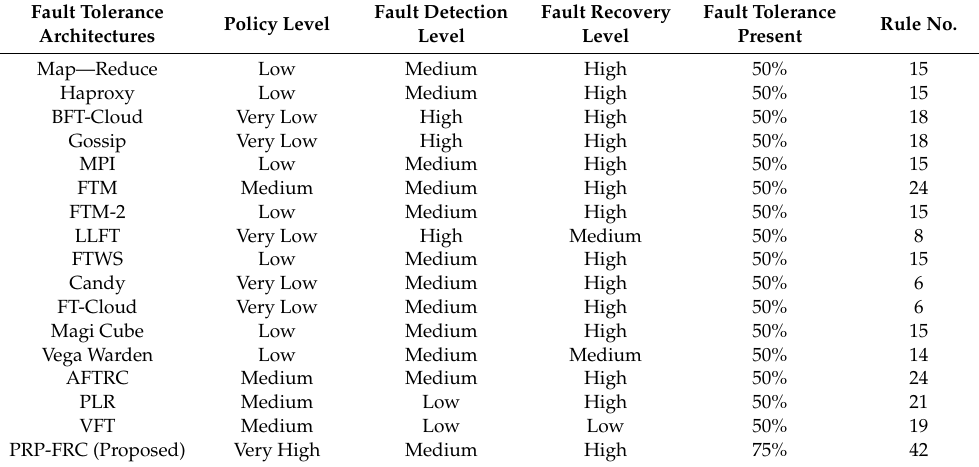
Table 10. Comparing FT capability of our proposed architecture with other existing architectures in the FIS (2)